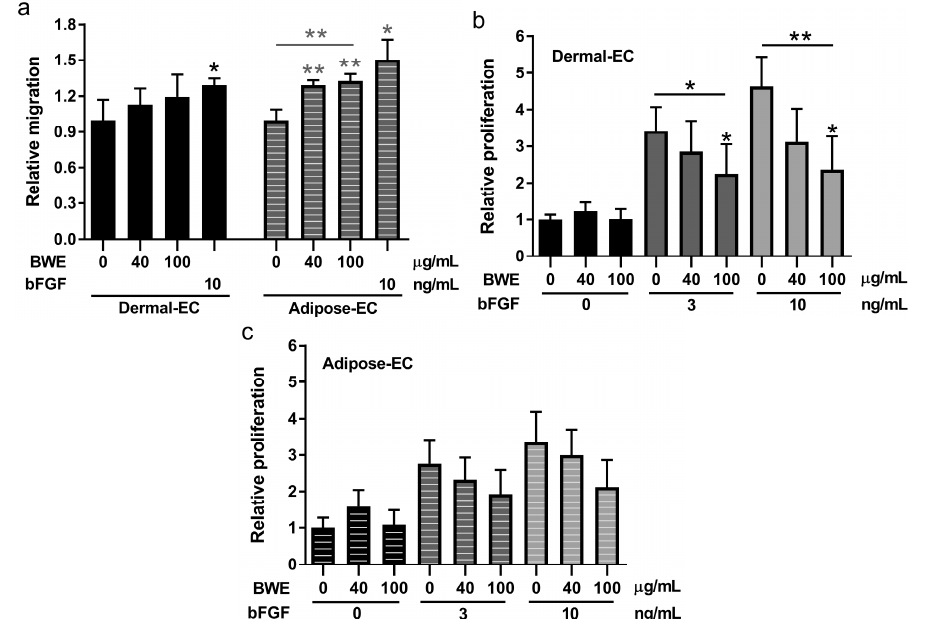
Figure 3. Migration scratch assay and proliferation assay using dermal- and adipose-endothelial cells. ( a ) Relative migration values of dermal- and adipose-EC cultured in the presence of 0, 40 or 100 µg/mL BWE or 10 ng/mL bFGF. Relative migration is calculated from the scratch area closed compared to unexposed endothelial cells; ( b ) Proliferation (3H incorporation) values, relative to unexposed endothelial cells, of dermal-EC cultured in the presence of 0, 3 or 10 ng/mL bFGF in combination with BWE; ( c ) Proliferation values, relative to unexposed endothelial cells, of adipose-EC cultured in the presence of 0, 3 or 10 ng/mL bFGF combined with BWE. Significance of the dose response curve was calculated using a one-way ANOVA followed by a Dunn’s multiple comparison test and significance of bFGF induction was tested with a t -test; * p < 0.05, ** p < 0.01. Data is shown for 4 independent experiments as mean ± SEM. Each experiment represents a different cell donor and a different BWE donor (see Table 1). Solid bars represent dermal-EC and striped bars adipose-EC.